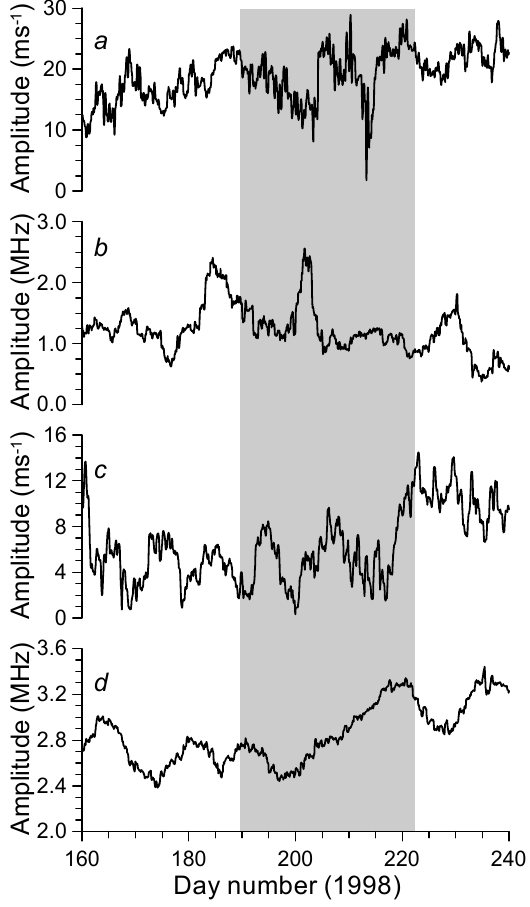
Fig. 10. Time development of the amplitudes of the 12-h oscillation of the meridional wind (a) and of the plasma frequency at 240km (b) , and of the amplitudes of the 24-h oscillation of the meridional wind (c) and of the plasma frequency at 240km (d)